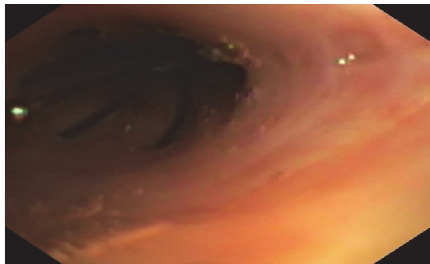
Figure 2: One of two endobronchial valves paced within the right middle